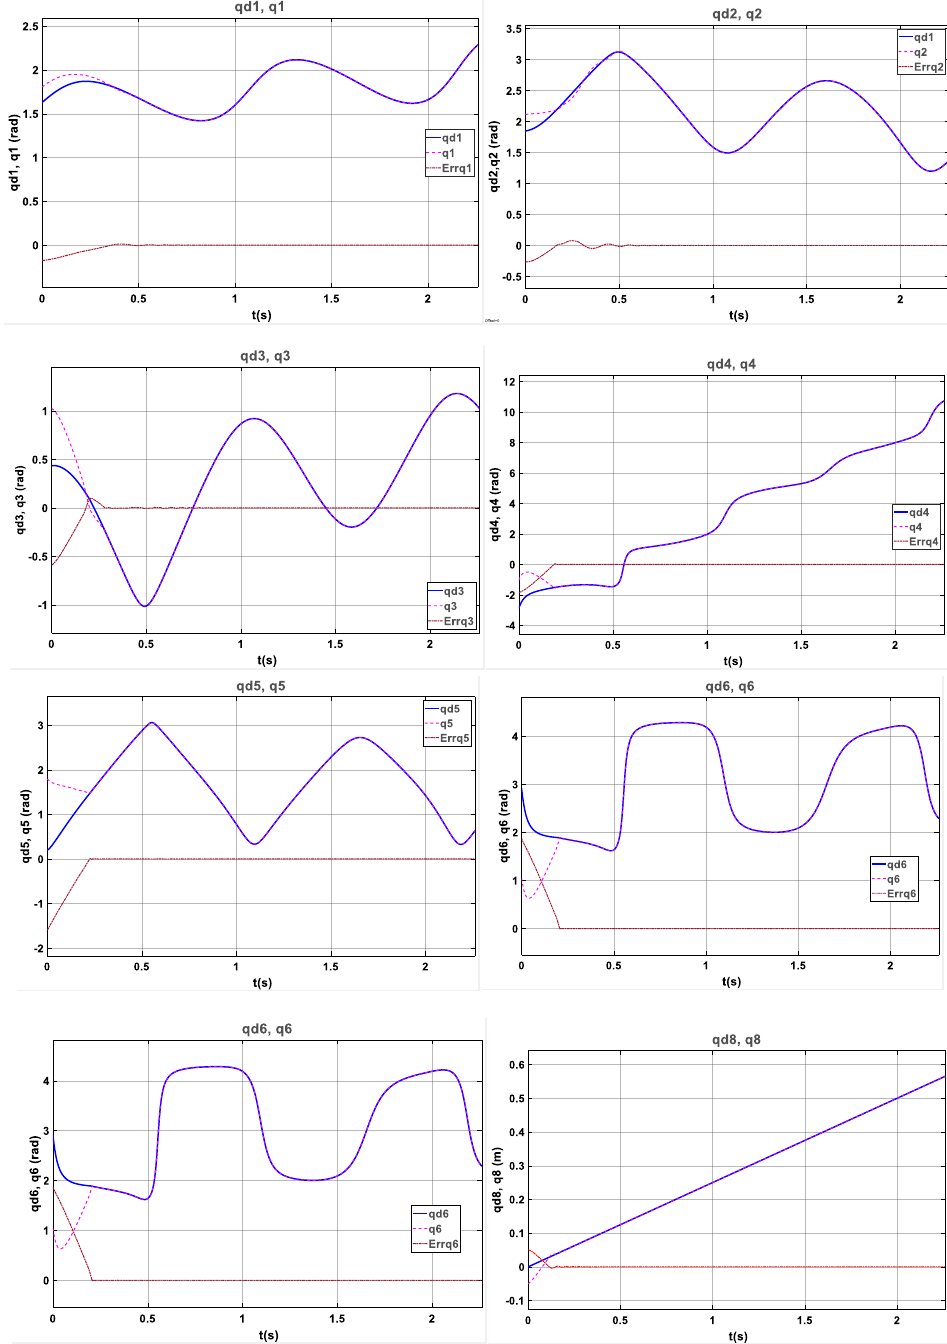
Figure 16. The simulation result of the fuzzy controller with initial trajectory error.